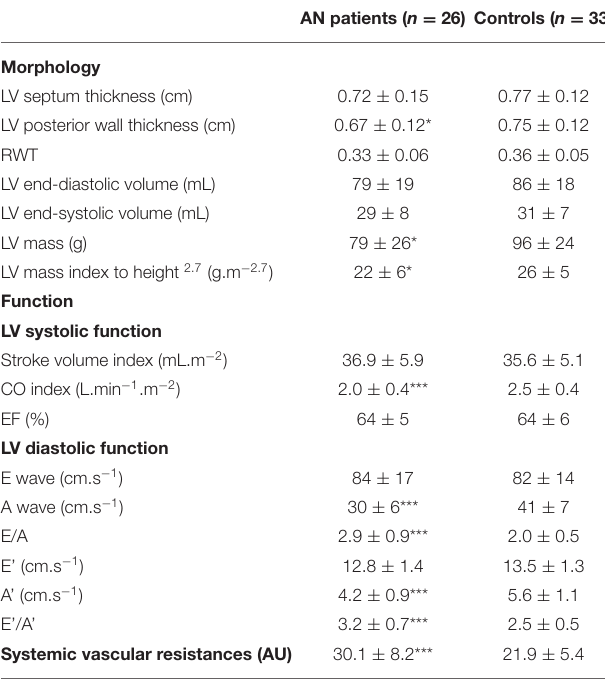
AN patients ( n = 26) Controls ( n =